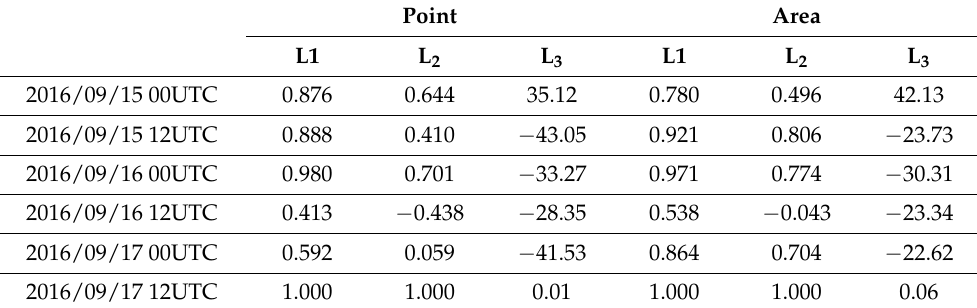
Table 12. LENS point discharge data results from 2016/09/15 00UTC to 2016/09/16